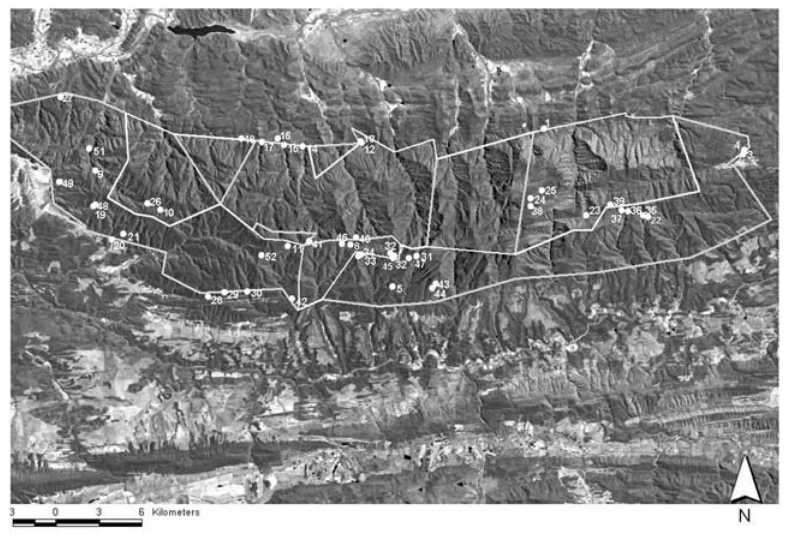
Fig. 3: Location of the vegetation communities of springs on the Kammanassie Nature